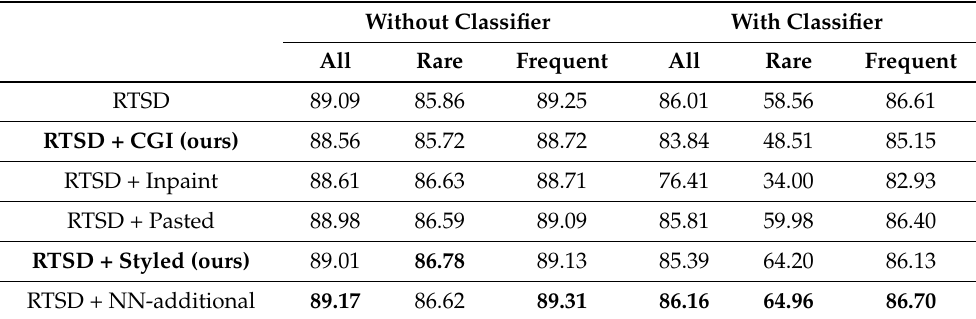
Table 2. Accuracy of PVANet [45] detector on a mixture of a real and synthetic samples with and without classifier [43]. Ours approaches are “RTSD + CGI” and “RTSD + Styled”. Numbers in bold indicate the best result in the